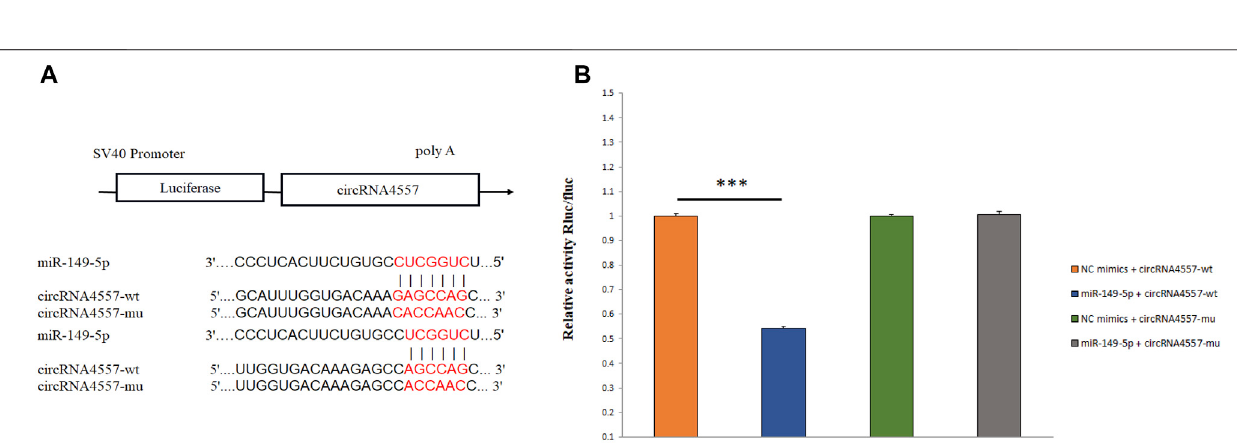
Frontiers in Genetics |